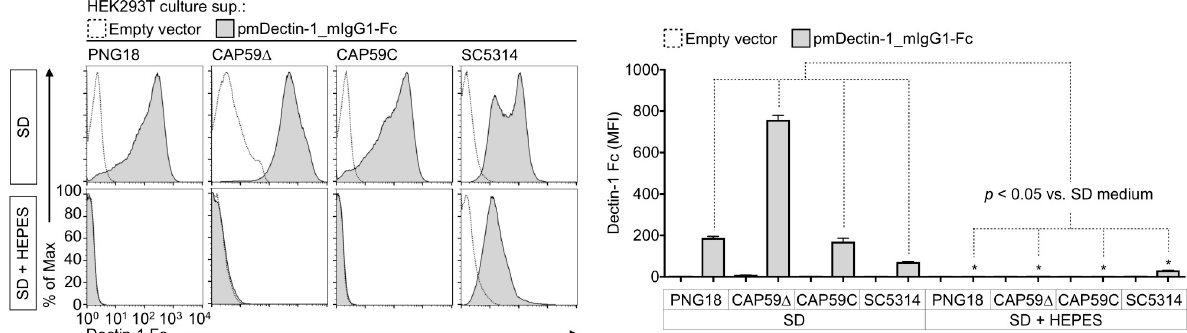
Fig 4. HEPES-buffered SD medium does not induce dectin-1 ligands on C . gattii . Deposition of Fc decin-1 on live fungal cells were evaluated via flow cytometry as described above. Representative bar graph (mean ± SDs) from three independent experiments are shown. � : P < 0.05 versus counterparts of SD medium without HEPES using an unpaired t